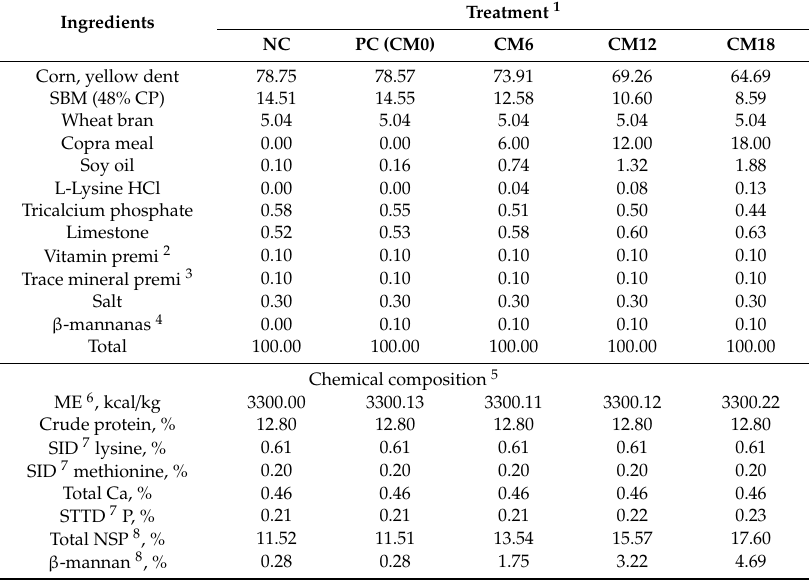
Table 4. The formula and chemical composition of experimental diets in finishing II phase.